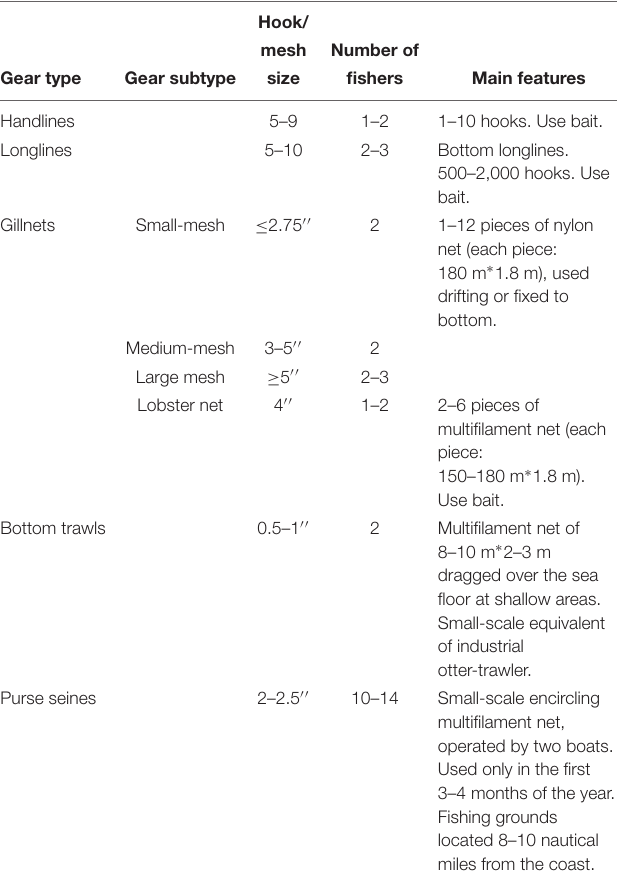
TABLE 1 | Characteristics of gear types and subtypes that contribute most to total SSF landings at the three zones of the Colombian Pacific included in the present